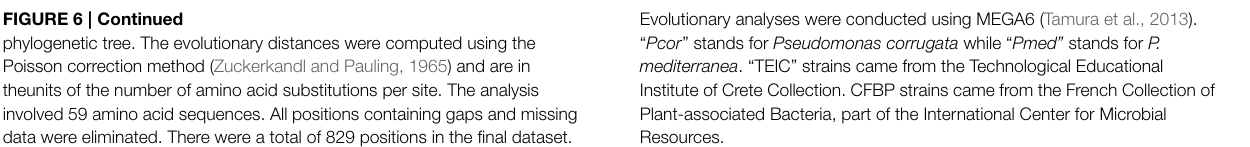
FIGURE 6 | Continued phylogenetic tree. The evolutionary distances were computed using the Poisson correction method (Zuckerkandl and Pauling, 1965) and are in theunits of the number of amino acid substitutions per site. The analysis involved 59 amino acid sequences. All positions containing gaps and missing data were eliminated. There were a total of 829 positions in the final dataset.